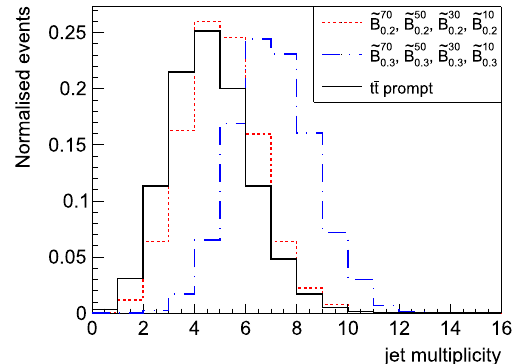
and 400 GeV, respectively) of the events match such a con- figuration. These values correspond to 73% and 64% for the bino case. This difference can be explained by the fact that the top quarks are produced closer to the beam in the bino case, leading to fewer top quarks in the tracker volume for small flight distances.